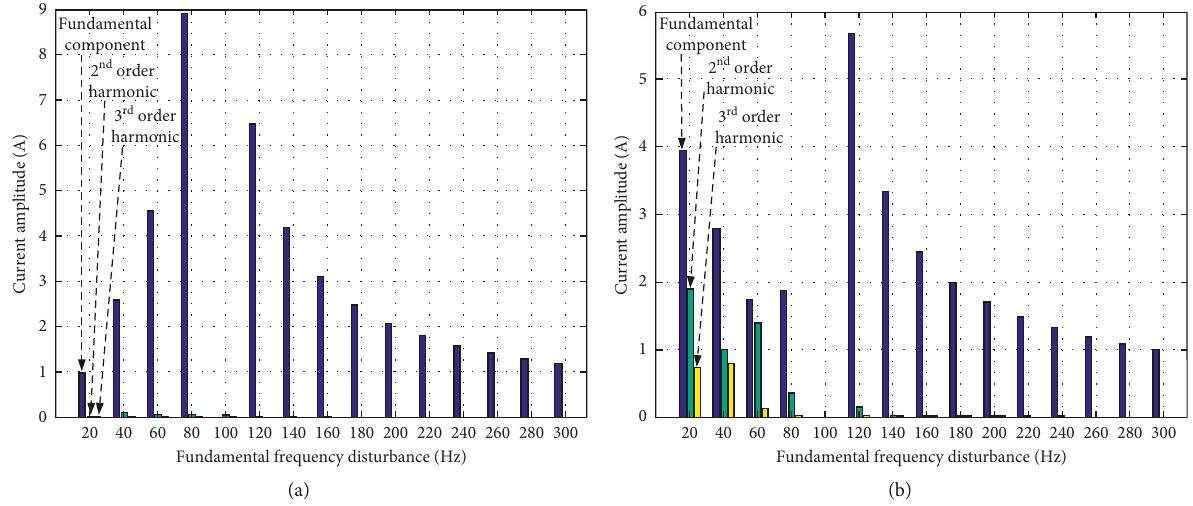
Figure 15: A comparison of output current magnitudes for the switching model in PLECS ™ for the WTG11 (first WTG) (a) and WTG17 (seventh WTG) (b) (fundamental component: injected harmonic